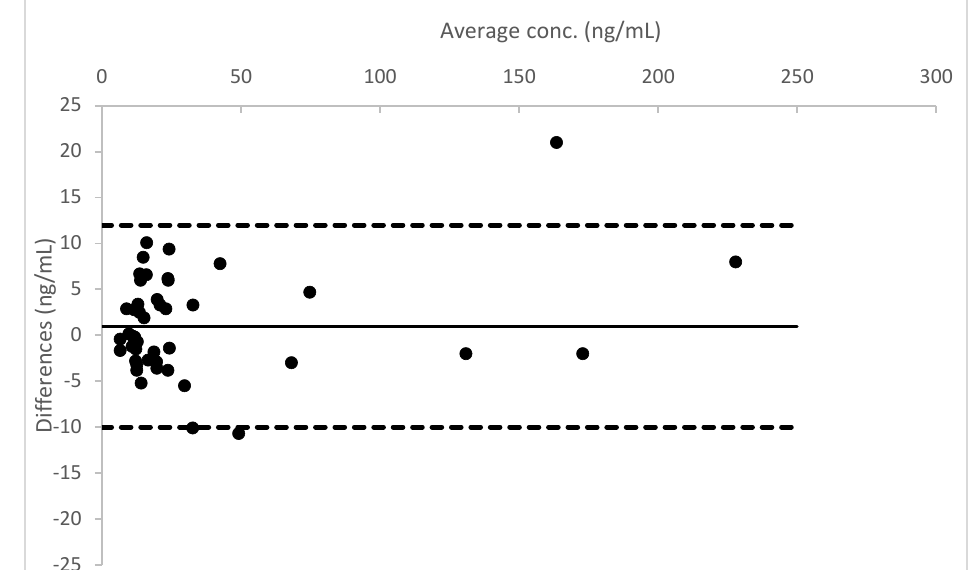
Figure 5. Bland – Altman plot for the results obtained from Whatman™ 903 card, in comparison to the data measured in liquid urine for THCCOOH.